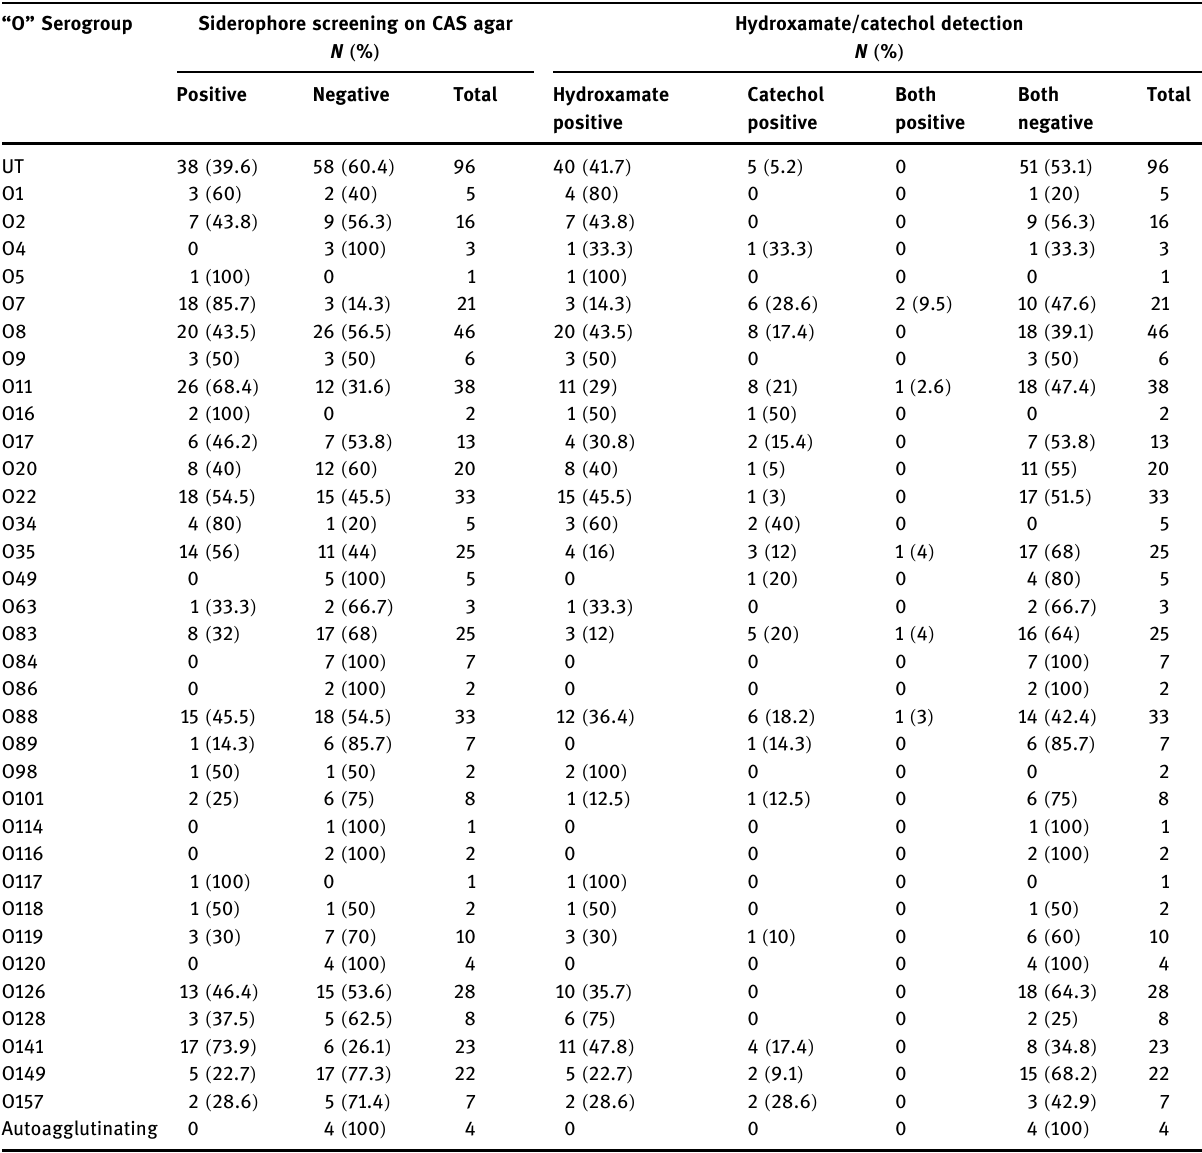
Table 3: Expression of siderophores and siderophore types by various E. coli “ O ” serogroups “ O ” Serogroup Siderophore screening on CAS agar N ( % )